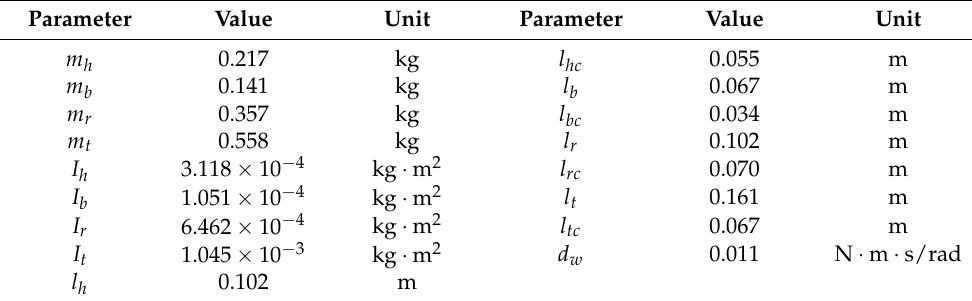
Table 3. Parameter values of model used to describe robot dynamics.